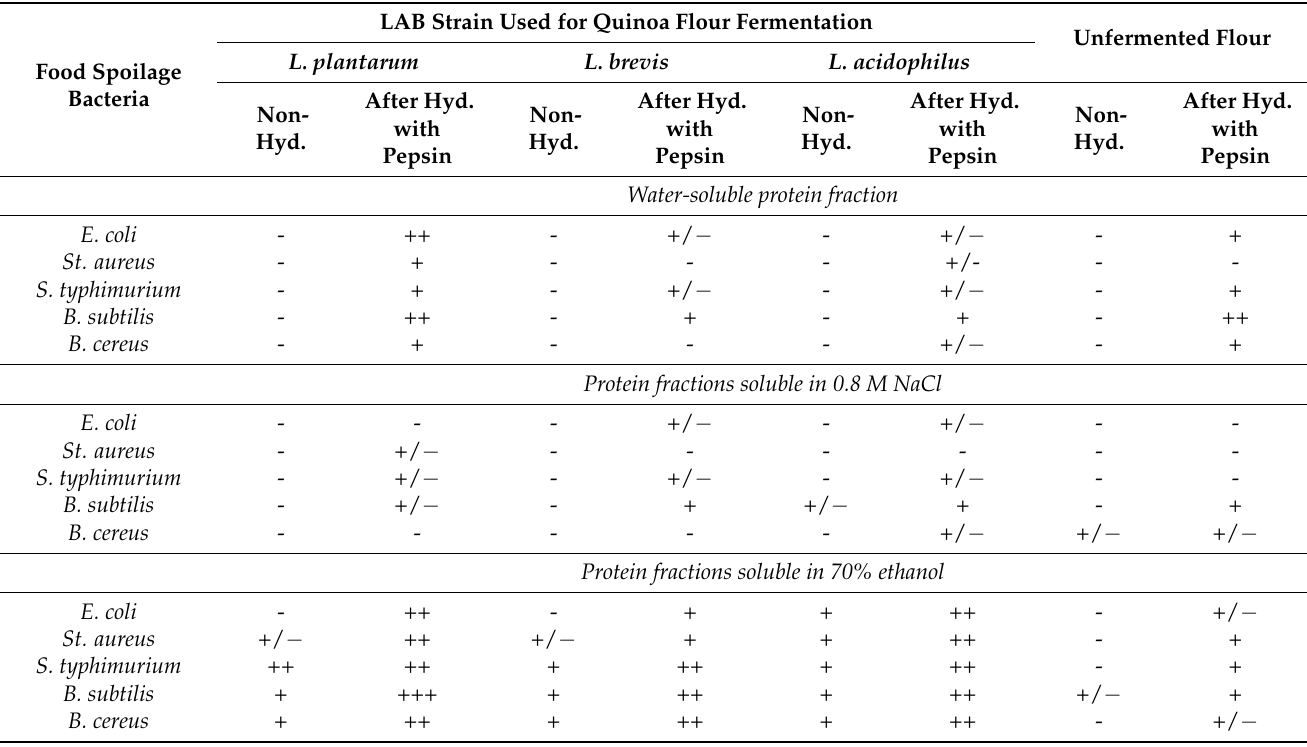
Table 3. Influence of fermentation with LAB and enzymatic hydrolysis with pepsin on antimicrobial properties of protein fractions from quinoa.